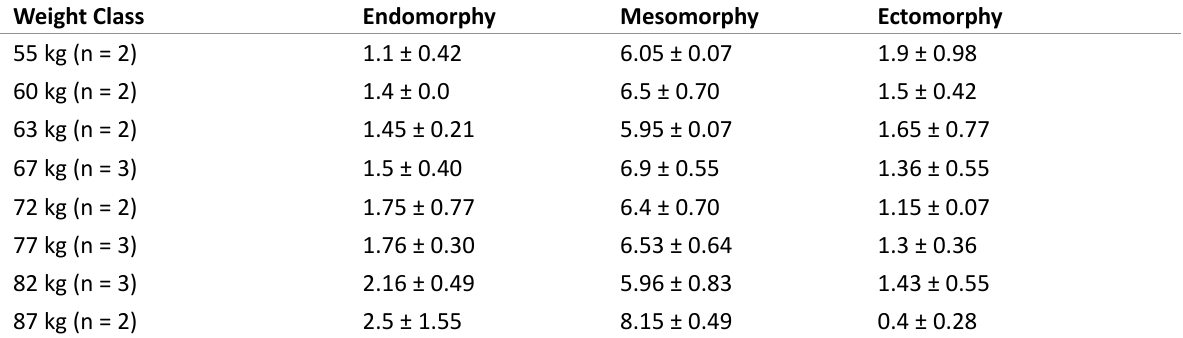
Table 5. Mean and standard deviation of somatotype of the elite Azerbaijani senior Greco-Roman